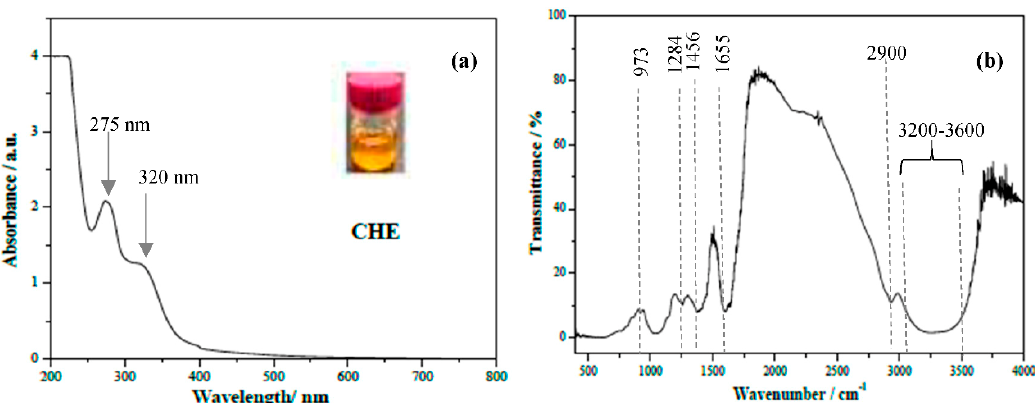
Figure 1. ( a ) UV-vis spectrum and ( b ) FTIR of the coffee husk extract (CHE).